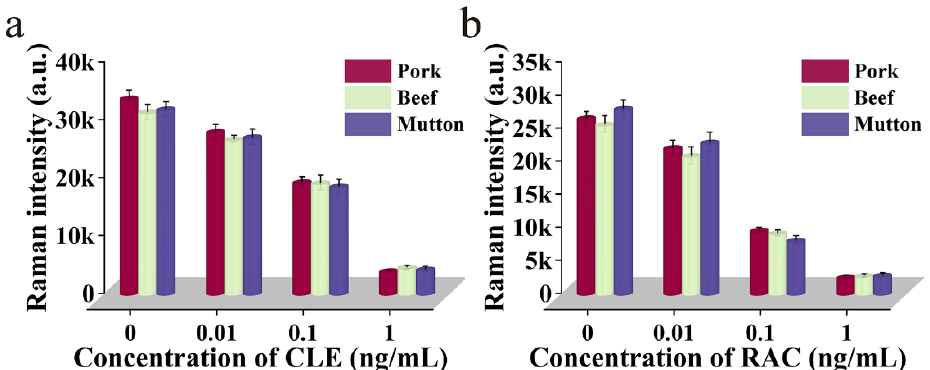
Figure 5. SERS signal intensity at 1331 cm − 1 of different concentrations of ( a ) CLE and ( b ) RAC in pork, beef, and mutton extracts. pork, beef, and mutton